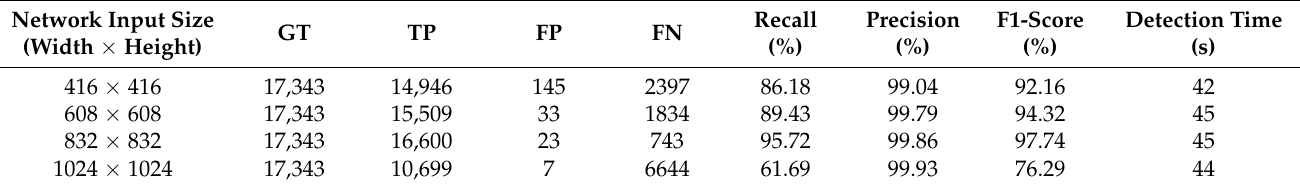
Table 11. YOLOv4 model evaluation results.